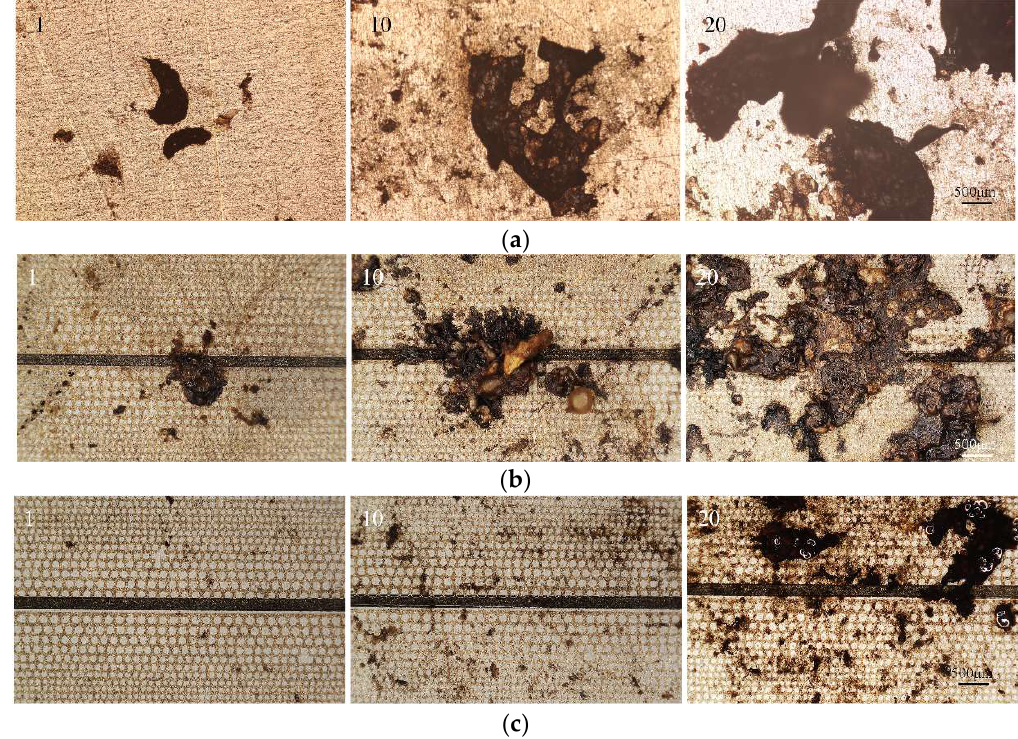
Figure 8. Soft tissue cutting cycle tests: ( a ) Tissue sticking on smooth surface at the first, 10th, 20th cycle tests; ( b ) tissue sticking on dry gradient surface at the first, 10th, and 20th cycle tests; ( c ) tissue sticking on self-lubricating slippery wettability gradient’s surface at the first, 10th, and 20th cycle tests.